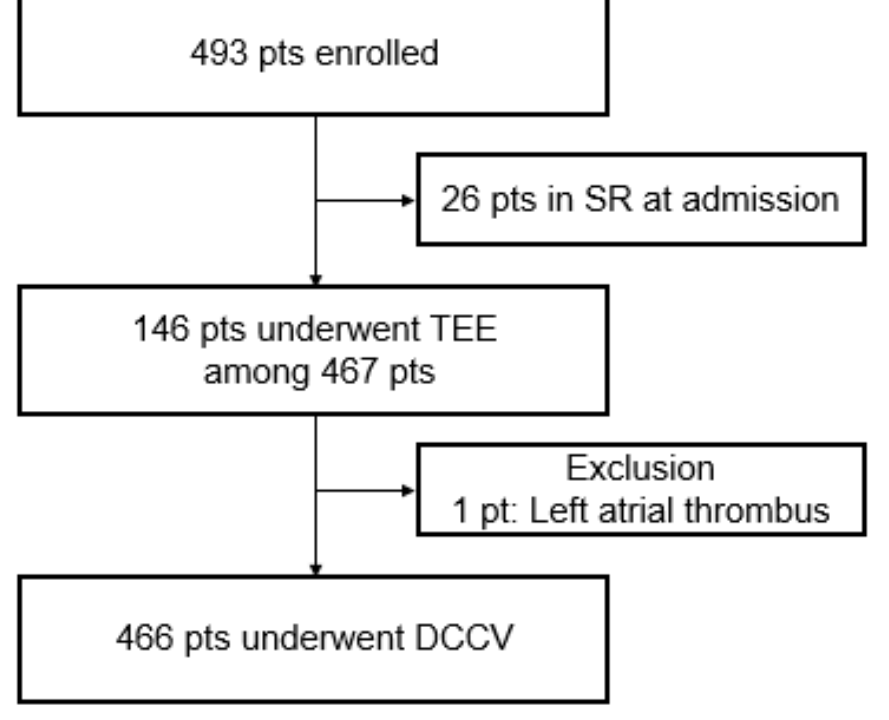
Figure 1. Flowchart of the study.